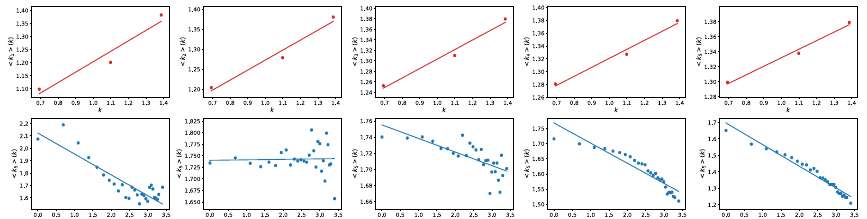
Fig. 19 Degree correlations of the two extreme cases of the LSwT model at distances from 1 to 5. The first row corresponds to the p = 0 , and the second to the p = 1 case. (cid:31) k m (cid:30) ( k ) is plotted against k on a log‑log scale, and the line fitted to the log‑transformed data is also provided